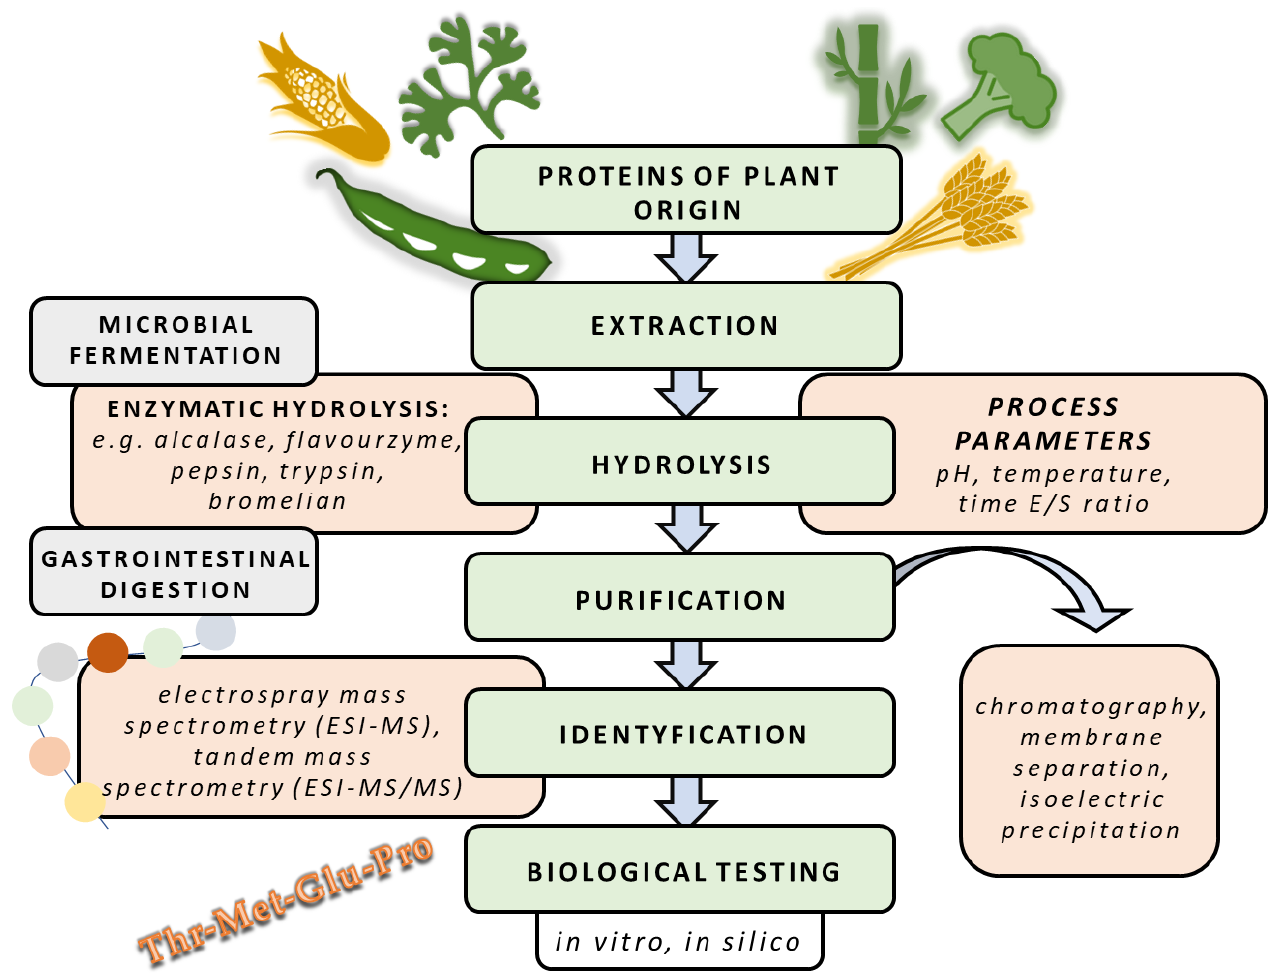
Figure 1. Diagram of bioactive peptide preparation from plant origin.